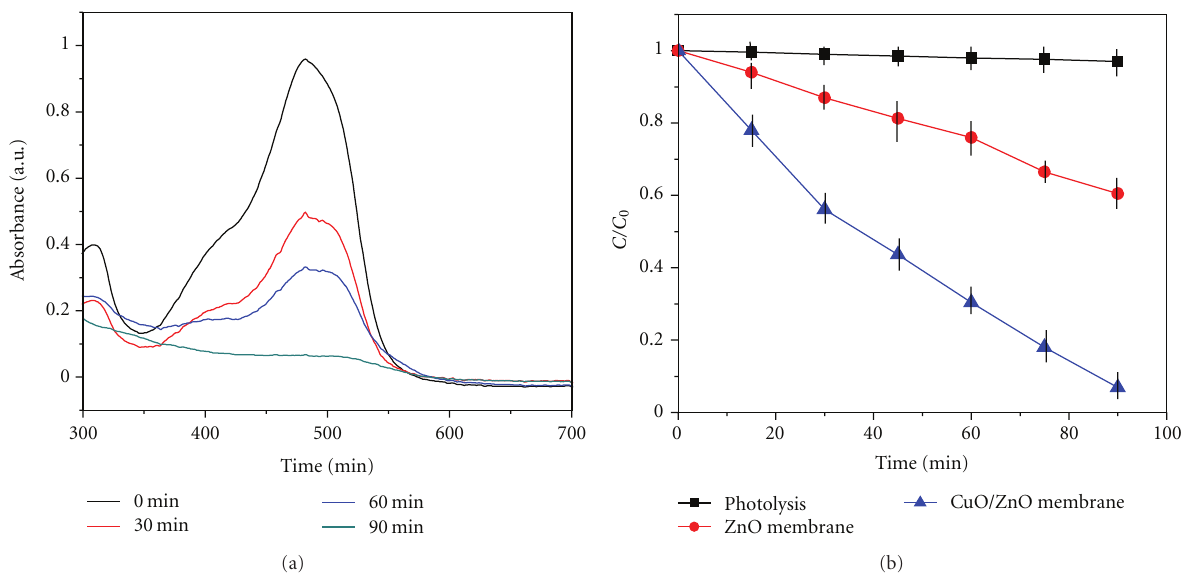
Figure 8: (a) The absorption spectra of AO7 solution under the irradiation of visible light on the CuO/ZnO membrane, and (b) the concentration change of AO7 solution under the irradiation of visible light on the CuO/ZnO membrane and ZnO membrane.